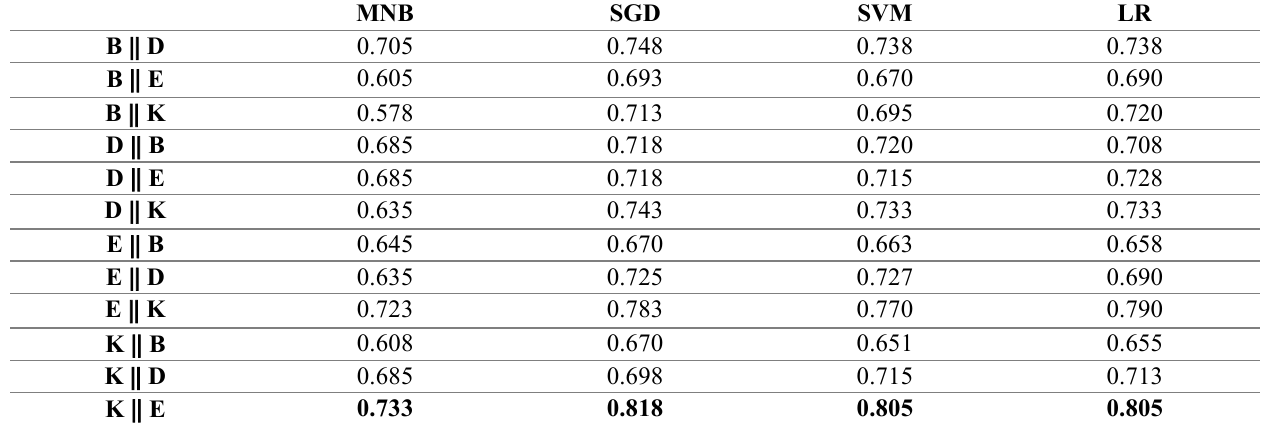
Table 7. CDSC results using traditional manually labels learning method